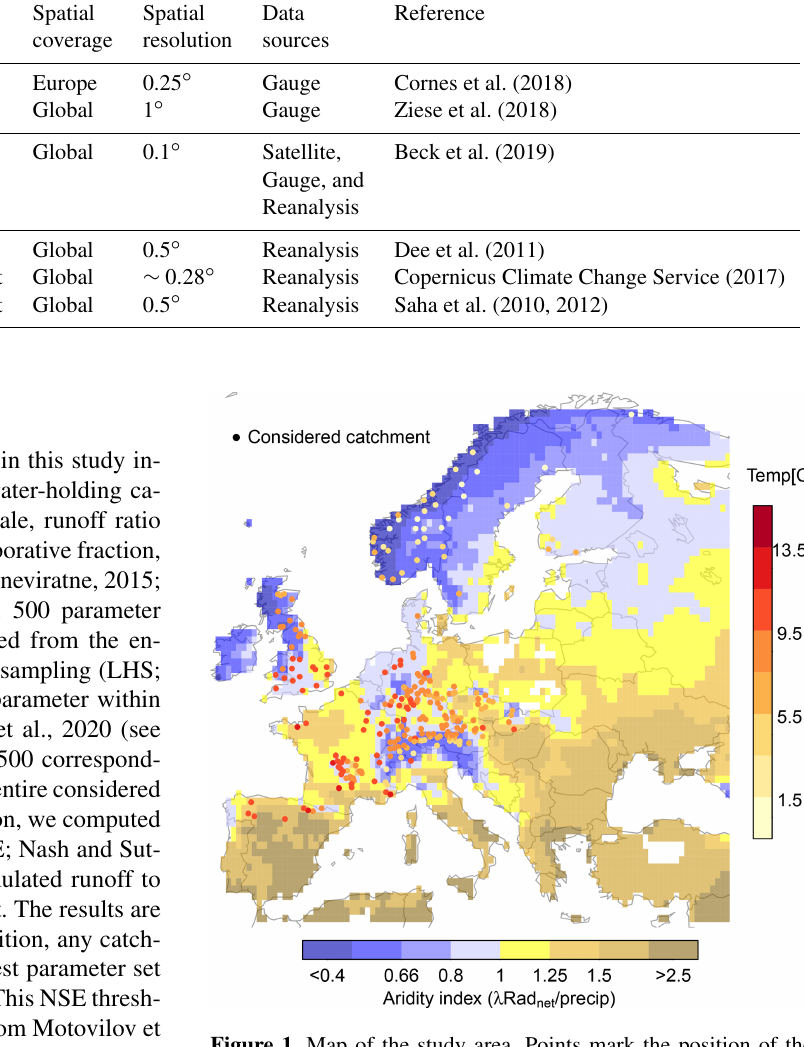
Figure 1. Map of the study area. Points mark the position of the 264 study catchments, with colors indicating their annual average temperature. Map colors show the aridity index of regions, as deter- mined by a ratio of long-term average net radiation and precipitation